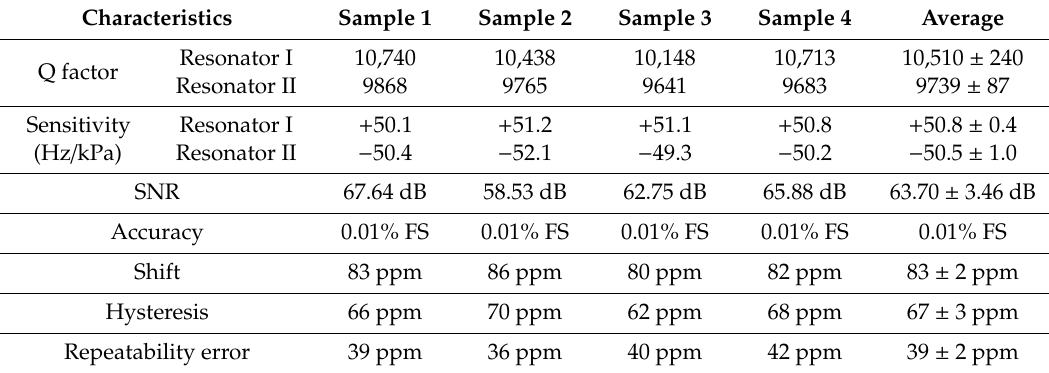
Table 1. Performance comparisons of this type sensors.